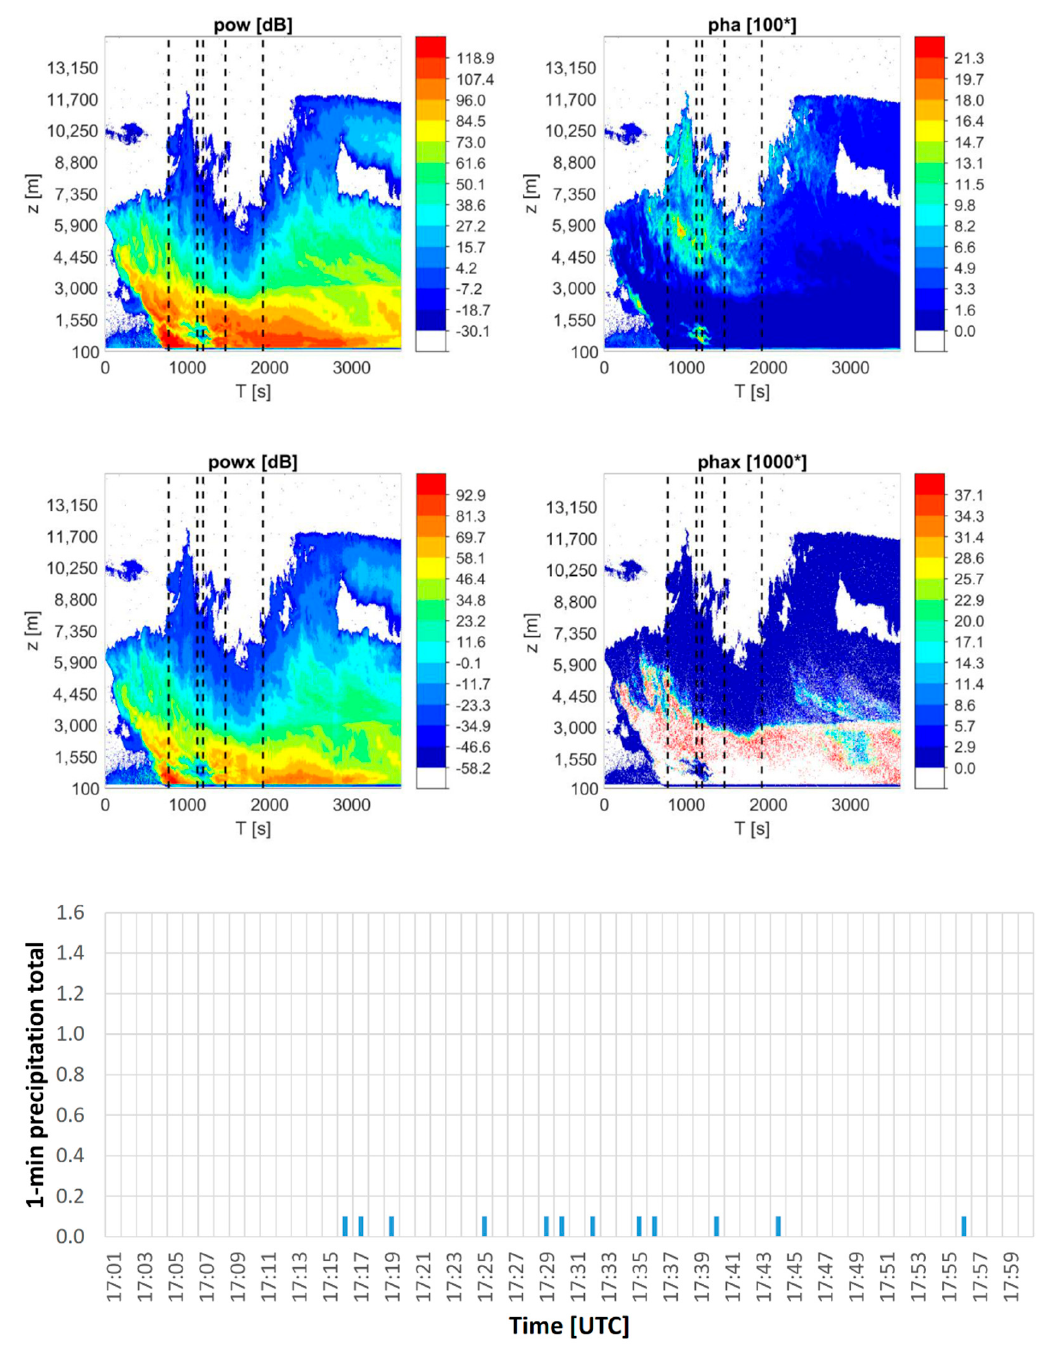
Figure 3. Time evolution of pow, pha, powx and phax (upper two rows) from 17:00 to 18:00 UTC on 2 August 2018. The x-axis shows time (T [s]), while the y-axis displays the height above the radar site (z [m]). Quantities pow and powx are in dB, whereas pha and phax are in arctan of phase degree multiplied by 100 and 1000, respectively. The dashed lines show the time of lightning discharges recorded up to 0.75 km from the radar site. The lower graph shows the 1-min precipitation totals as measured during the same period by the automated weighting rain gauge situated next to the cloud radar.